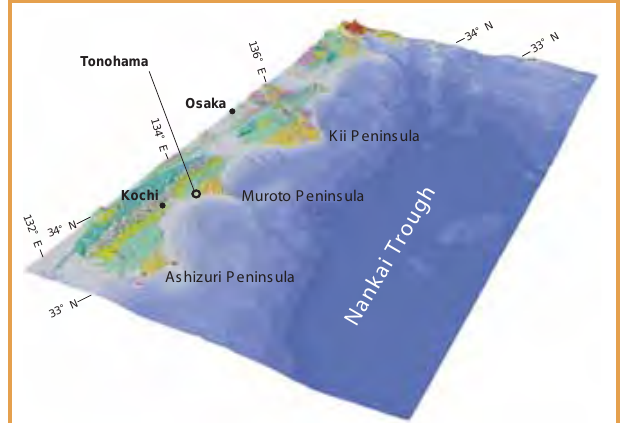
Figure 1. Oblique view of Pacifi c coast of southwestern Japan and adjacent submarine topography. Map is based on data from Editorial Group for Computer Graphics, Geology of Japanese Islands (2002).